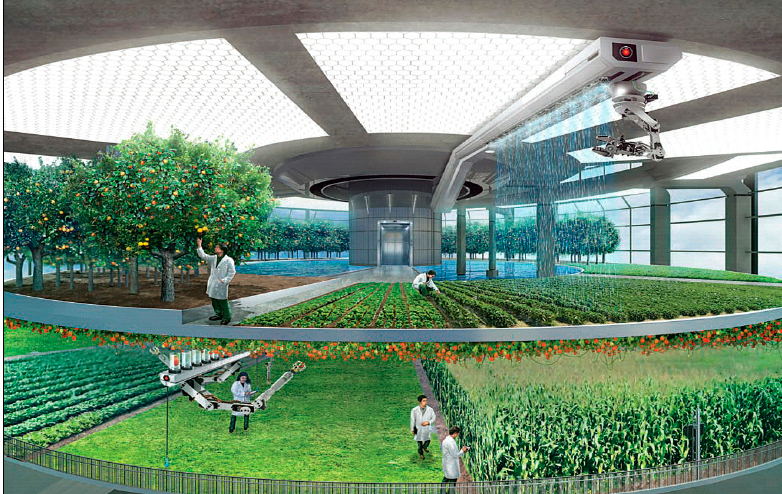
Figure 6. Structure of the inner layout of the urban smart vertical farm. Reprinted with permission from ref. [25]. Copyright 2021 Scientific. Net.